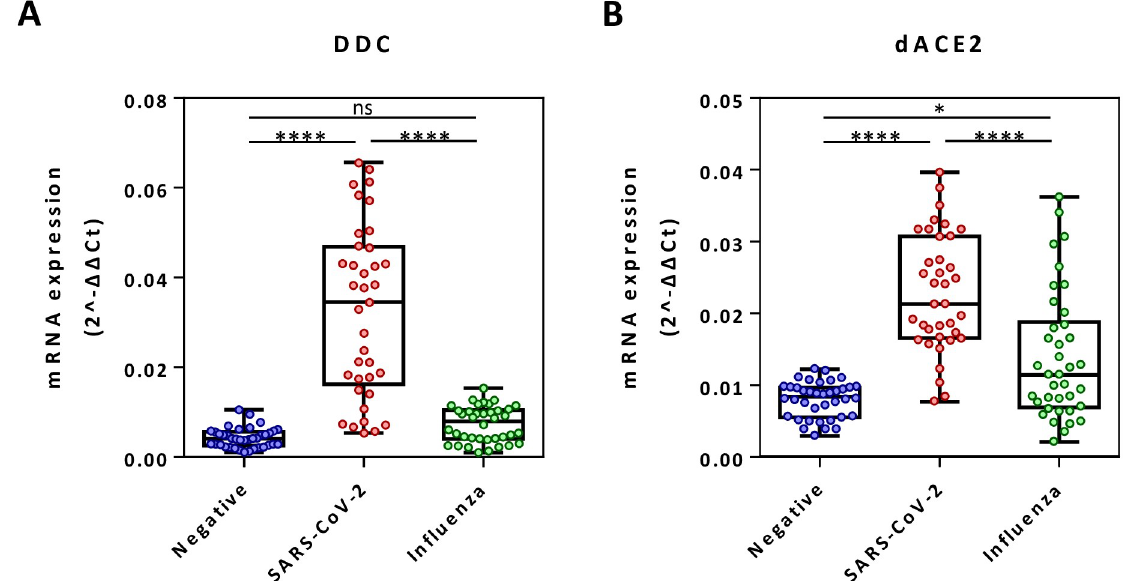
Fig 4. Comparing DDC and dACE2 mRNA levels of influenza A/B-positive nasopharyngeal swab samples with the ones from SARS-CoV-2 positive and negative samples. mRNA values (mean 2 - ΔΔ Ct ) from the influenza-infected group (n = 38) compared to the ones from the SARS-CoV-2 (n = 37) and negative control (n = 38) groups of Fig 1. Data are represented as box plots; line in the middle, median; box edges, 25 th to 75 th centiles; whiskers, range of values. p values were calculated with Kruskal-Wallis